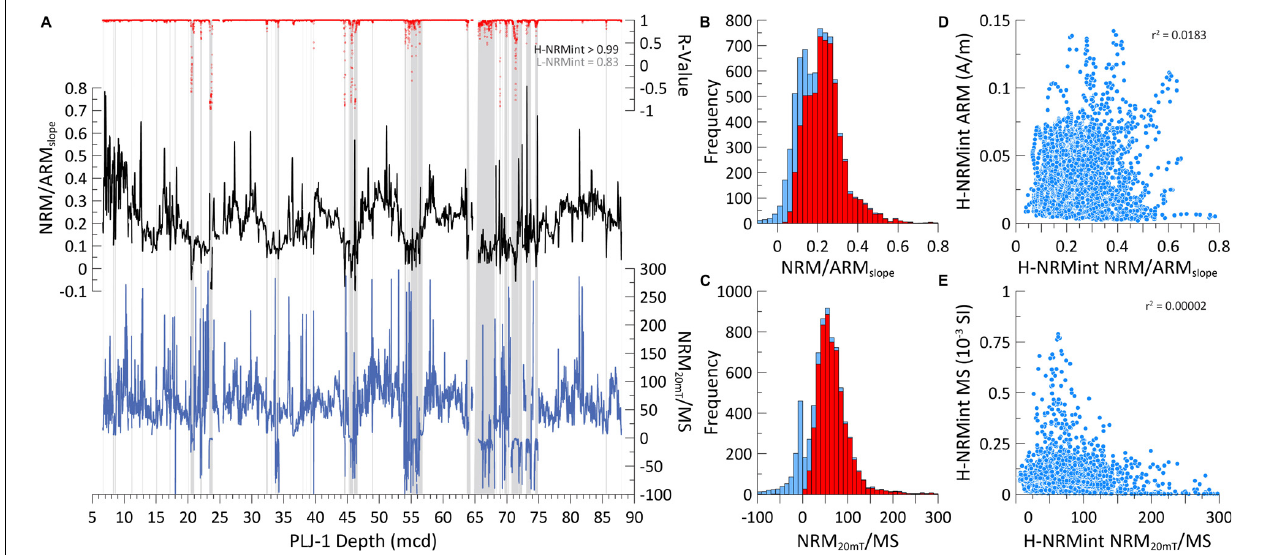
FIGURE 7 | (A) Normalized remanence ratios NRM 20 mT /MS (blue) and NRM/ARM slope (black) values and the associated R -value (red). Gray vertical shading highlights NRM 0 mT intensity values below a threshold of 1 × 10 - 3 A/m as in Figure 6 . Median R -values of data with NRM intensity higher than the threshold (H-NRMint) exceed 0.99 while R -values of data with NRM intensity lower than the threshold (L-NRMint) are much lower; median values of these two populations are annotated. (B) Distribution of all NRM/ARM slope data (blue) and the H-NRMint NRM/ARM slope data (red). (C) Distribution of all NRM 20 mT /MS data (blue) and the H-NRMint NRM 20 mT /MS data (red). Note the L-NRMint data are biased toward lower, and in the case of NRM 20 mT /MS negative, values. (D) NRM/ARM slope values plotted against ARM intensity values for the H-NRMint dataset. (E) NRM 20 mT /MS values plotted against MS values for the H-NRMint dataset. Note the lack of correlation between the normalized ratio and its normalizer for the H-NRMint datasets suggesting little influence of bulk magnetic concentration parameters on the normalized